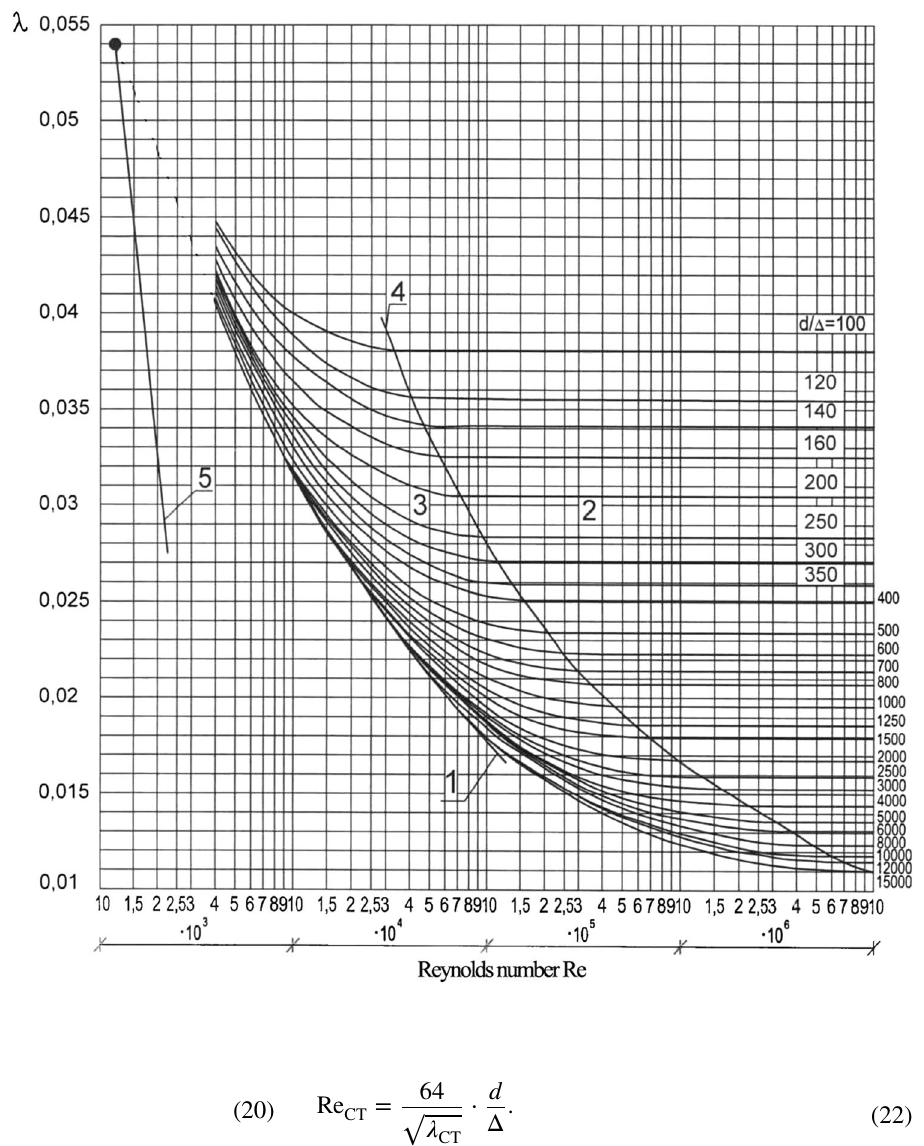
Fig. 1 Murin’s graphs: 1 is a curve of hydraulically smooth pipes, constructed according to the Blasius equation; 2 is a region of quadratic law of hydraulic resistance; 3 is a transition region; 4 is a curve separating the transition region and the quadratic law region; and 5 is a laminar regime